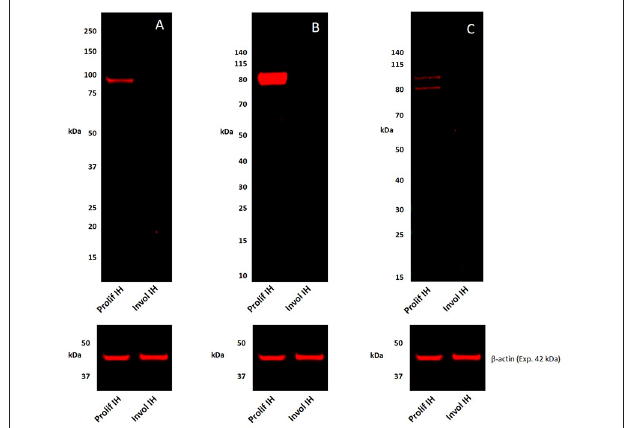
Figure 2 | Representative 1DE Western blot images of separated total protein extracts of a proliferating and an involuted IH samples probed for pSTAT1 (a) , pSTAT3 (B) , and pSTAT5 (c) and detected with HRP conjugated goat anti-rabbit secondary antibody. β -actin was used as the loading control and detected using Alexa® 647 rabbit anti-mouse secondary antibody (a–c)